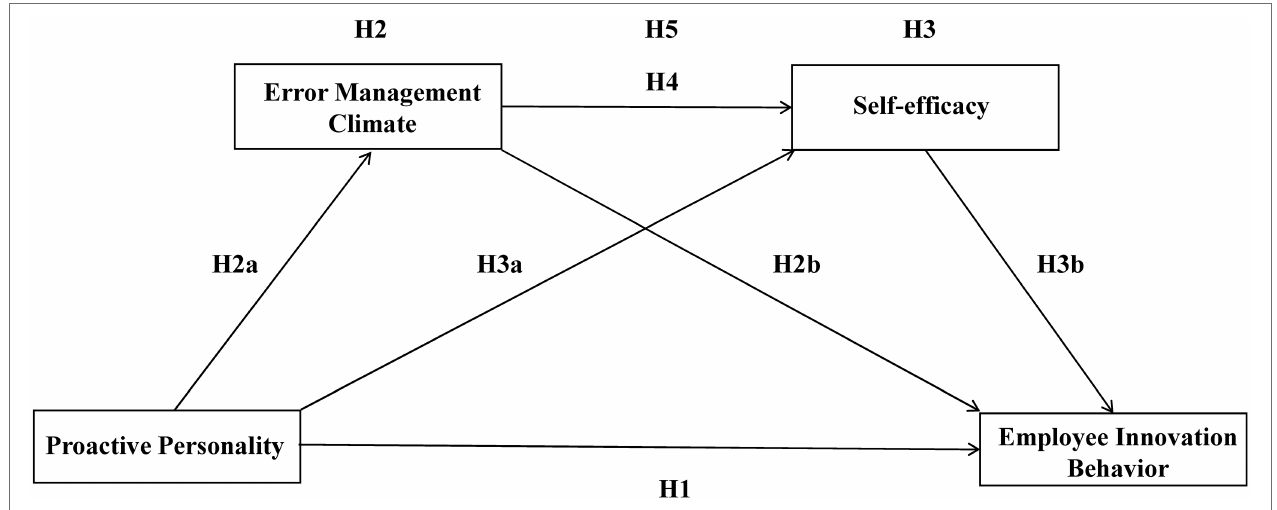
FIGURE 1 | Theoretical